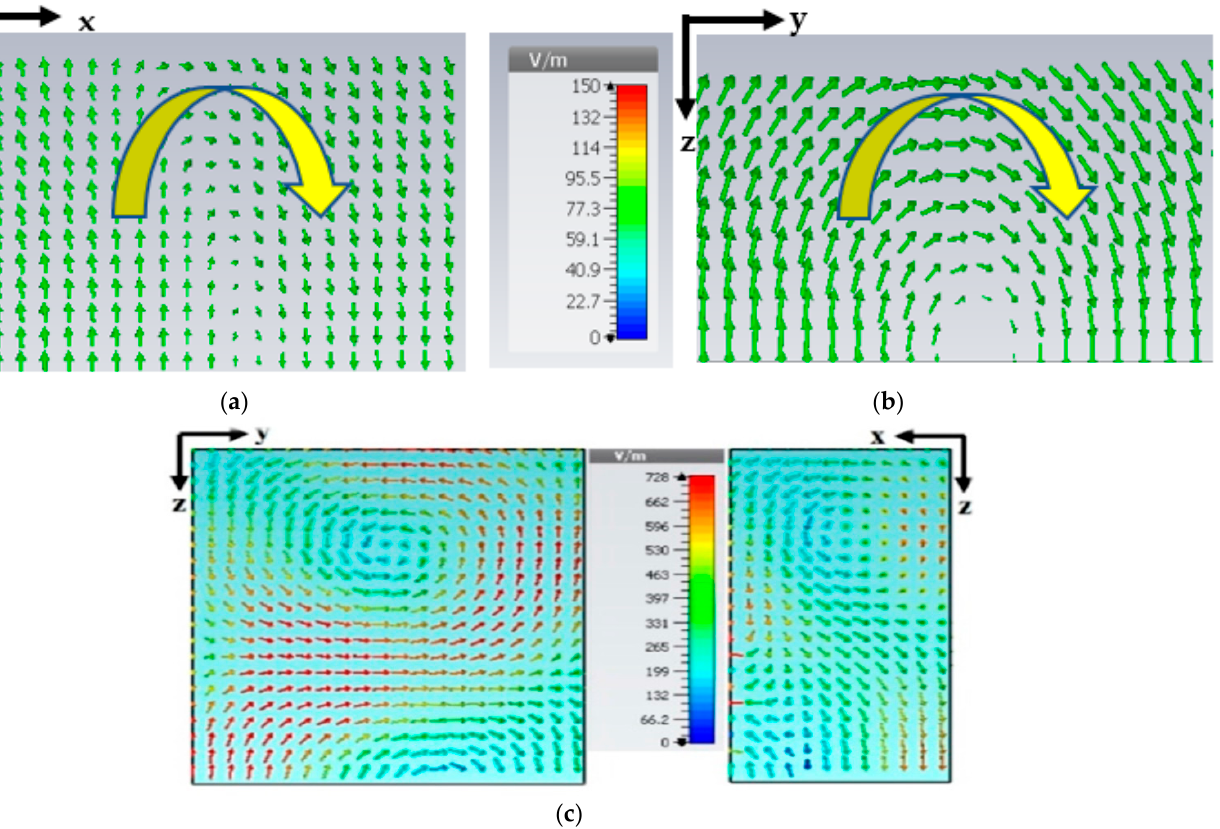
Figure 5. E-field distributions of RDRA designs in fundamental modes single feed ( a ) TE 111 at 3.7 3.7 GHz. ( b ) cross shape TE 111 at 3.41 GHz. ( c ) cross shaped-higher-order mode (TE 113 ) at 4.20